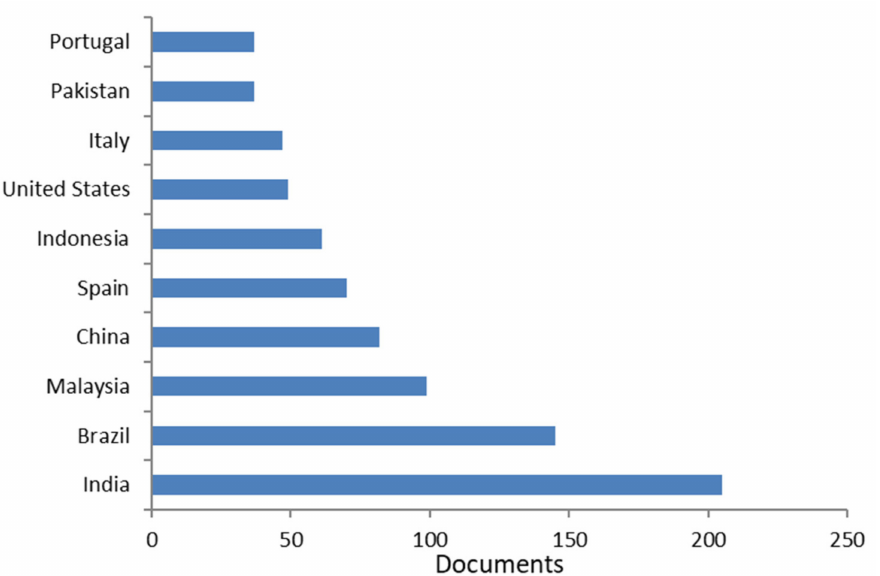
Figure 4. Most productive countries/territories (Bibliometric data were extracted from the Scopus online